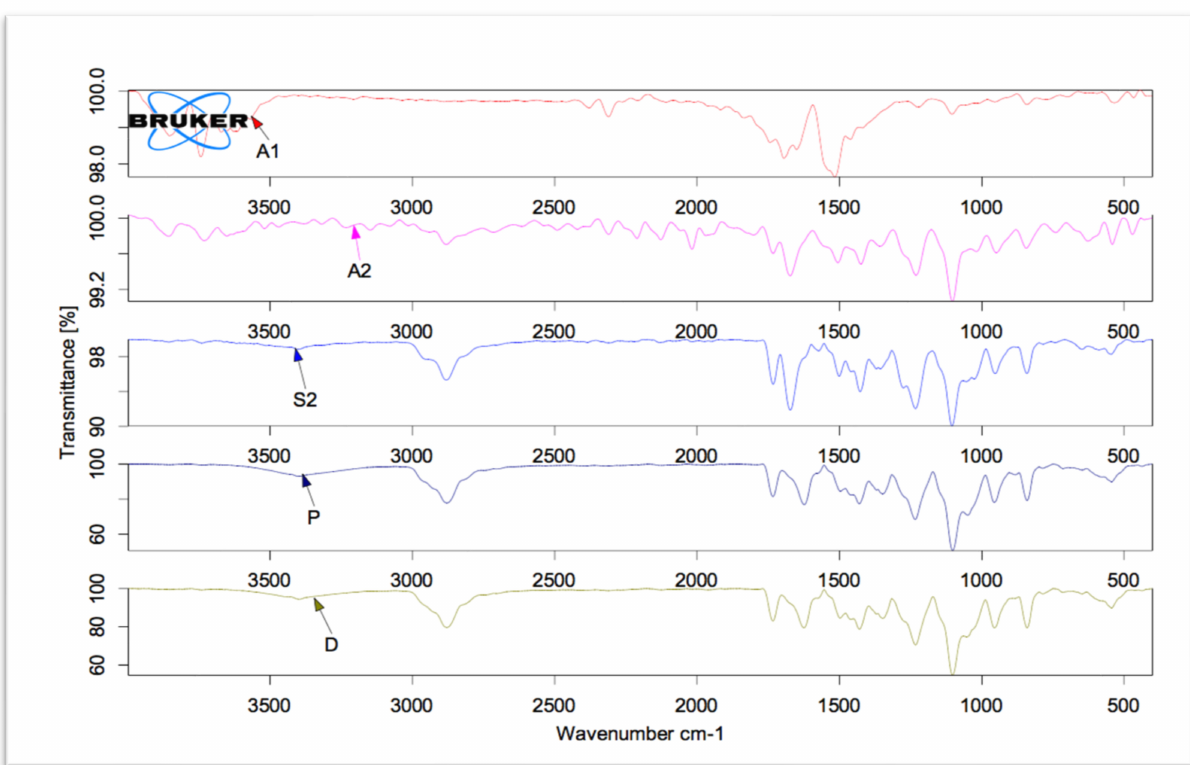
Figure 5. Fourier transforms intra-red (FTIR) spectra for pure Gef and different Gef-SDs formulations prepared using fusion